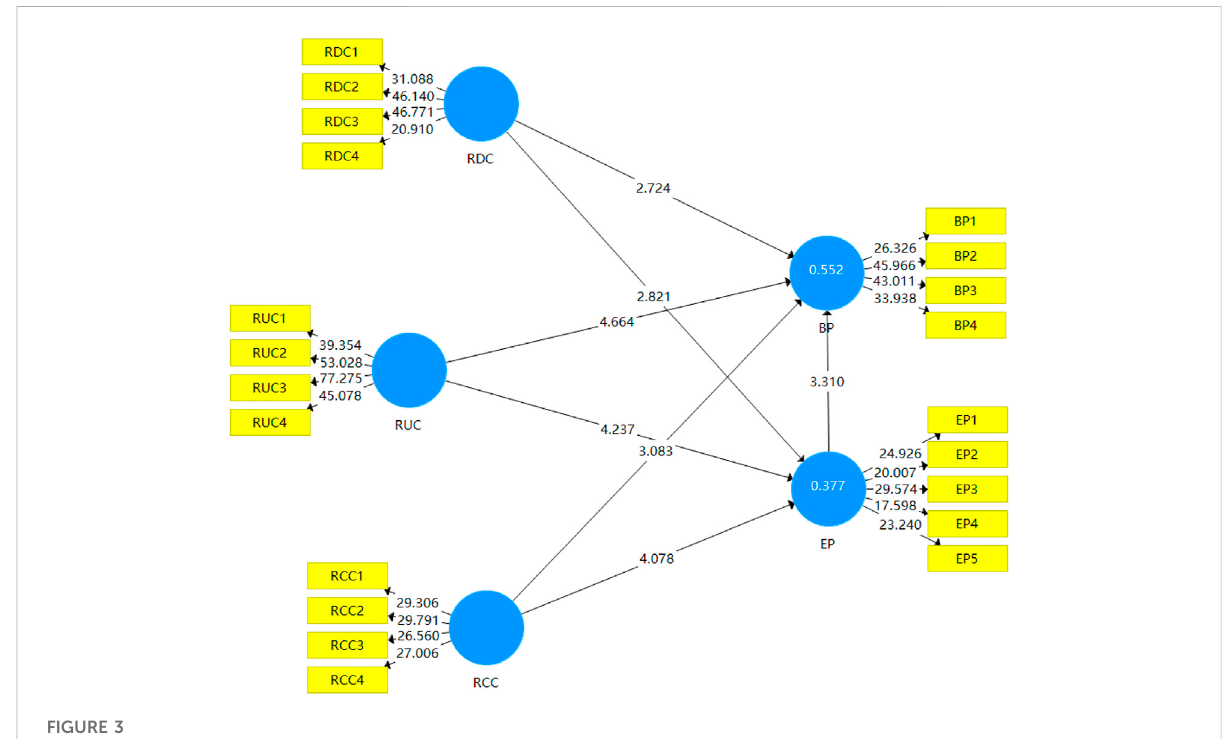
FIGURE 3 Structural model